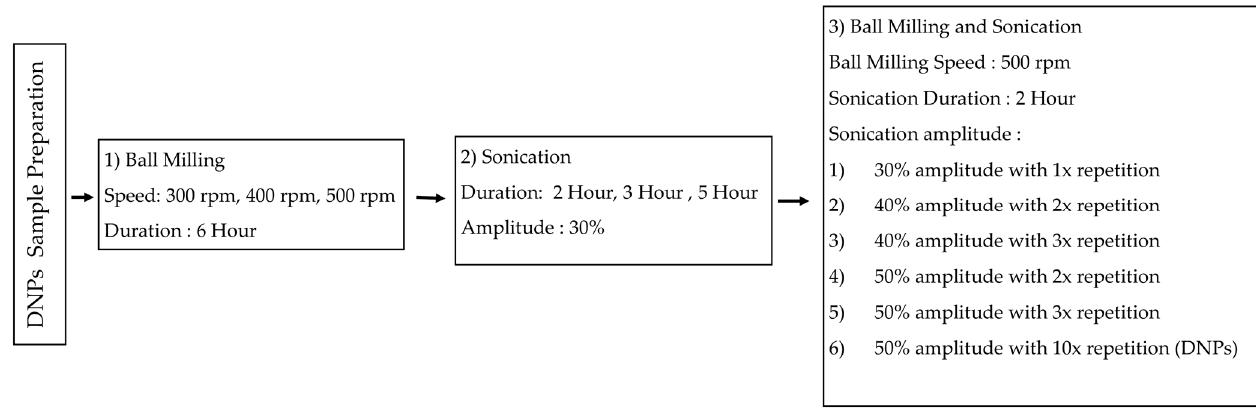
Figure 15. The preparation of dolomite nanoparticles (DNPs). Table 4. Ball-milling and sonication parameters for dolomite samples.